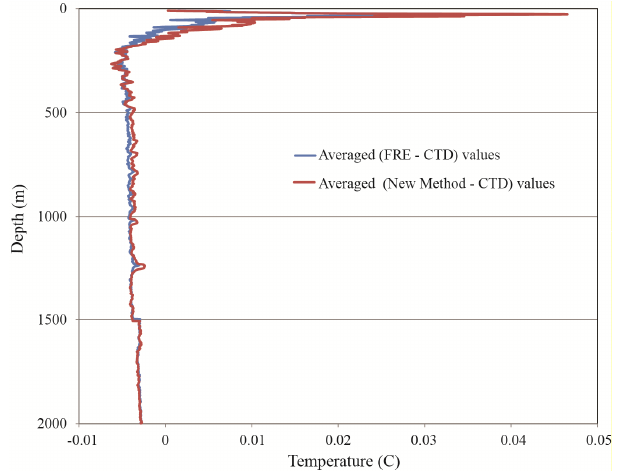
Fig. 8. Comparison of averaged differences between the new Fig. 8 – Comparison of averaged differences between the new method and CTD experiments with differences using the FRE approach and CTD experiments. method and CTD experiments with differences using the FRE ap- proach and CTD experiments.